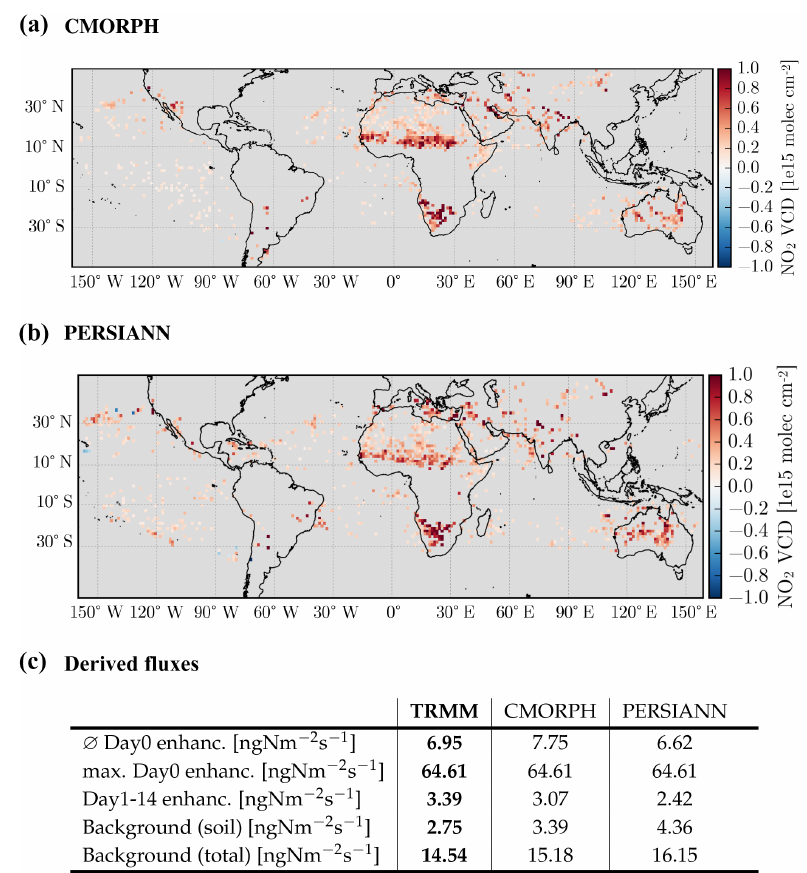
Figure E1. In this figure, the impact of the precipitation product on the derived soil NO x emissions is investigated. Panels (a, b) depict the NO 2 enhancement on Day0 as in Fig. 3d, but based on CMORPH and PERSIANN data, respectively. While the absolute values differ for the Sahel, the final emission estimates for pulsed emissions are quite similar (see panel c ), as the choice of the precipitation data affects the background correction as